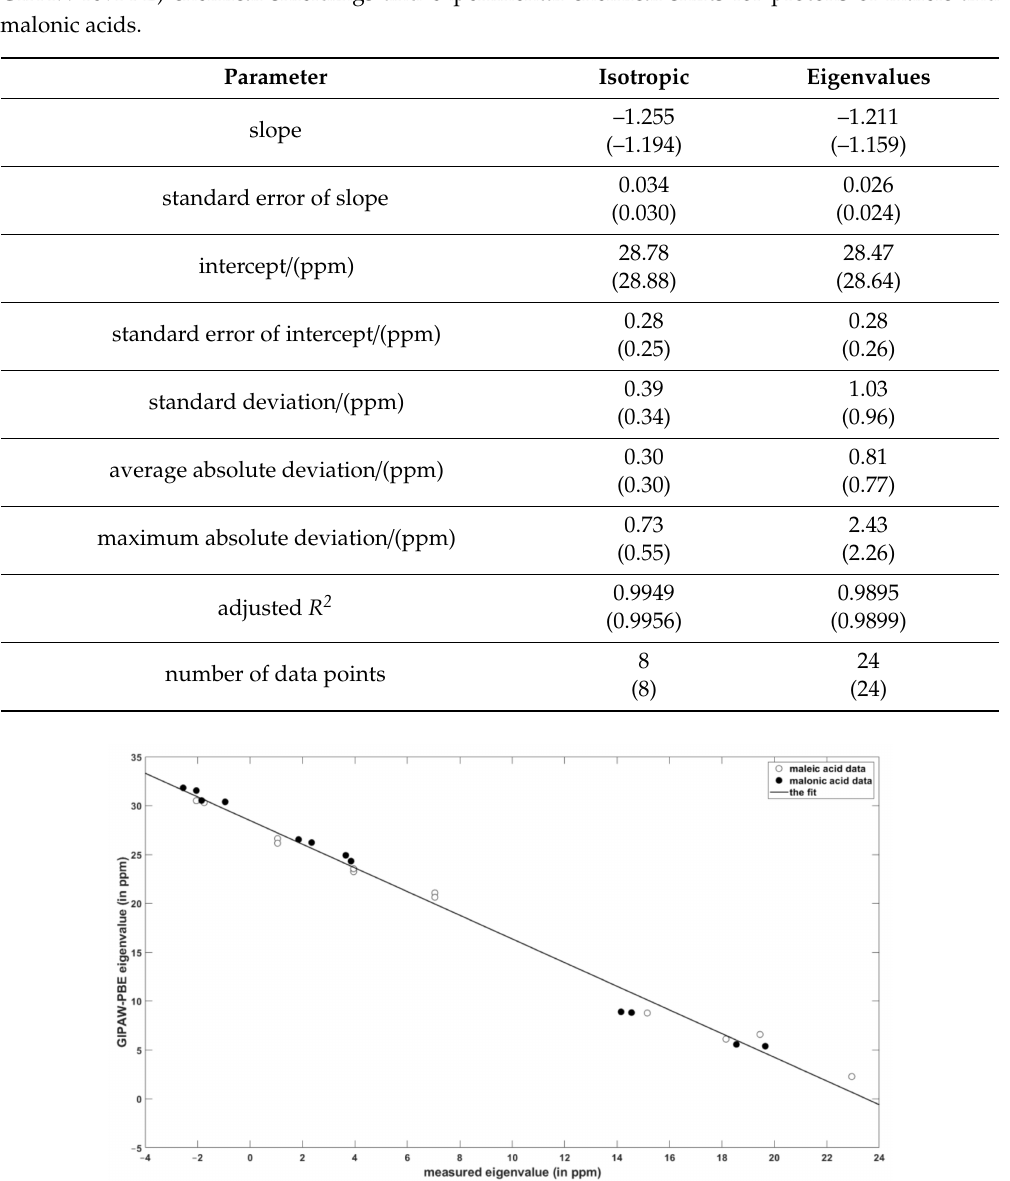
Figure 1. The correlation of the calculated and experimental values of the principal elements of the 1 H chemical shielding / shift tensors in maleic and malonic